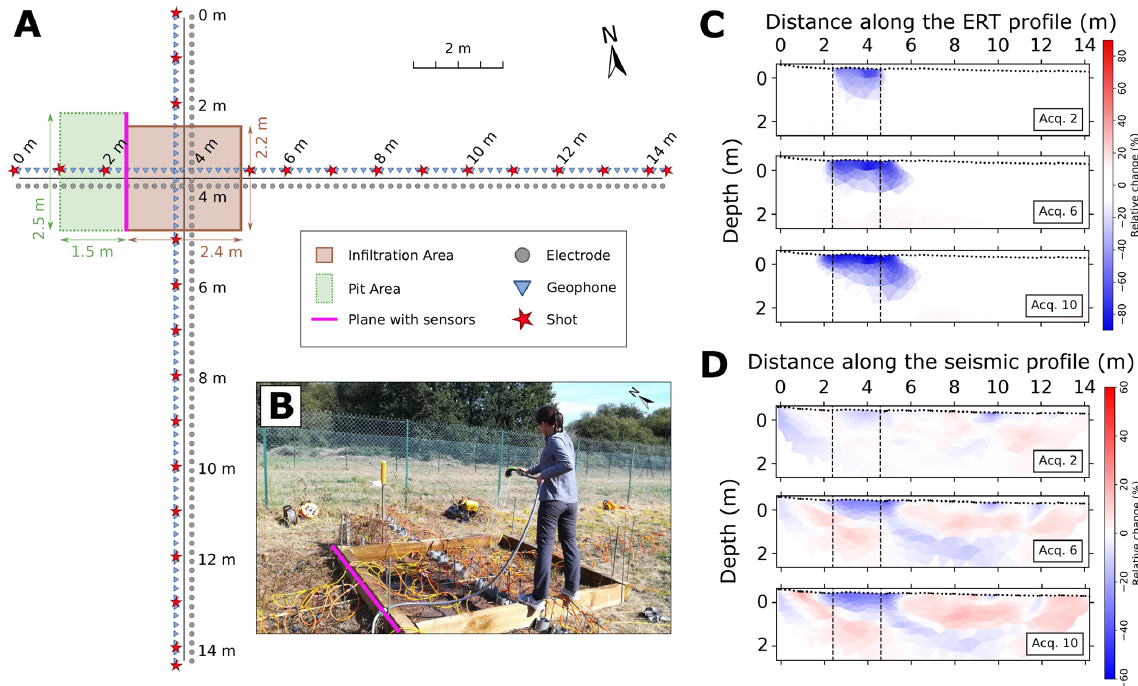
Figure 4. (a) Acquisition setup used by Blazevic et al. (2020) to jointly monitor the infiltration of water with ERT and seismic lines cross in the infiltration area. (b) Picture of the infiltration test, above a pit instrumented with TDR. Temporal evolution of relative change in properties inferred from (c) the ERT and (d) the seismic data along the North–South profile at different times (i.e., successive acquisitions) during the infiltration, respectively (modified after Blazevic et al., 2020, Table 2B1). One can see the preferential water flow from North to South, indicating lateral flow in the vadose zone.